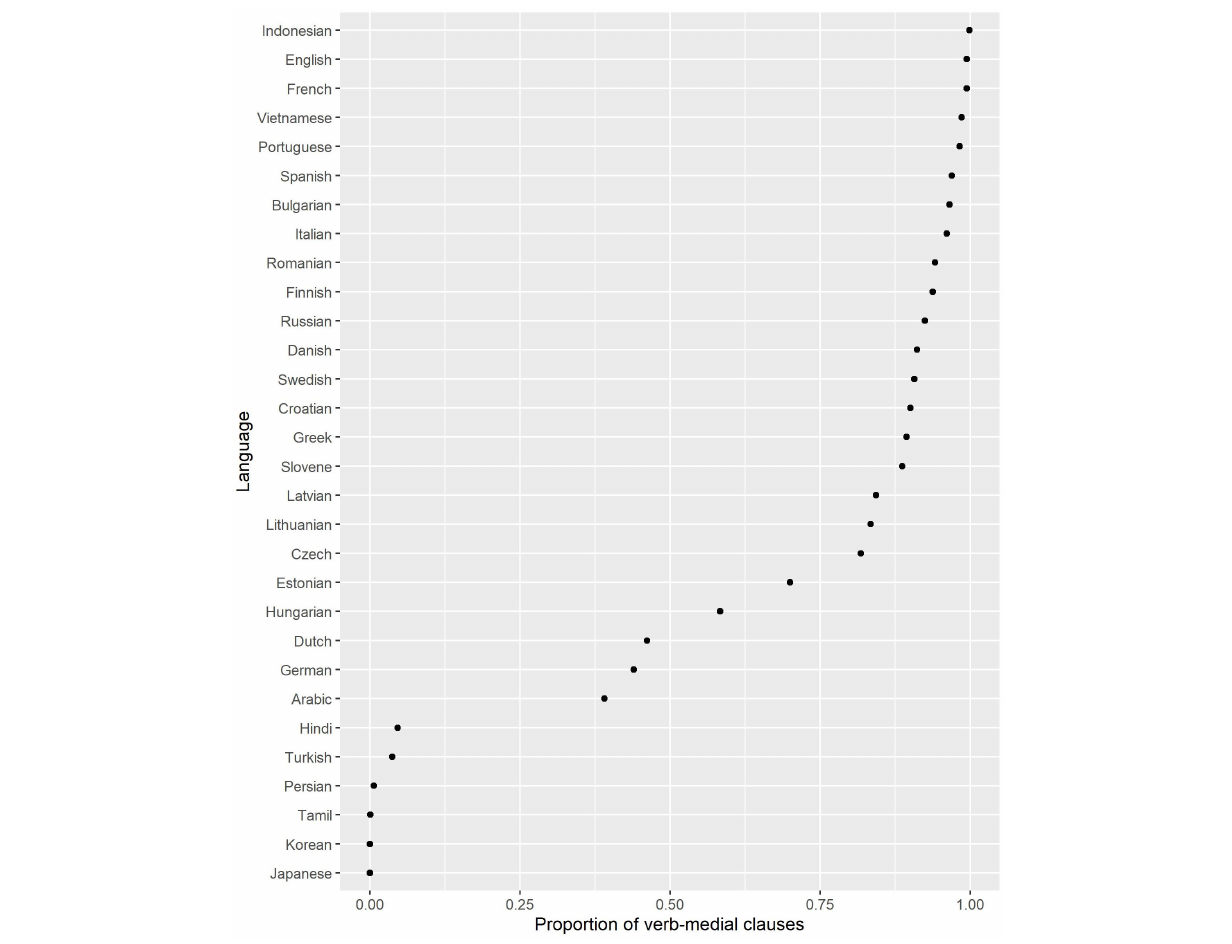
statistics based on the unpermuted data. These proportions served as p -values. The p -values were then averaged across the 1,000 samplings from the